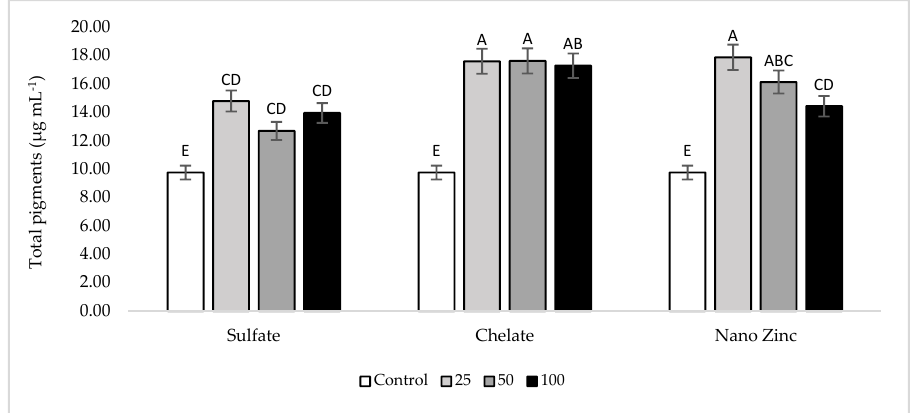
Figure 6. Total pigment concentration in leaf of bean cv. Strike as a result of applying nanofertilizers, chelates, and zinc sulfates. Letters shoe significant differences.